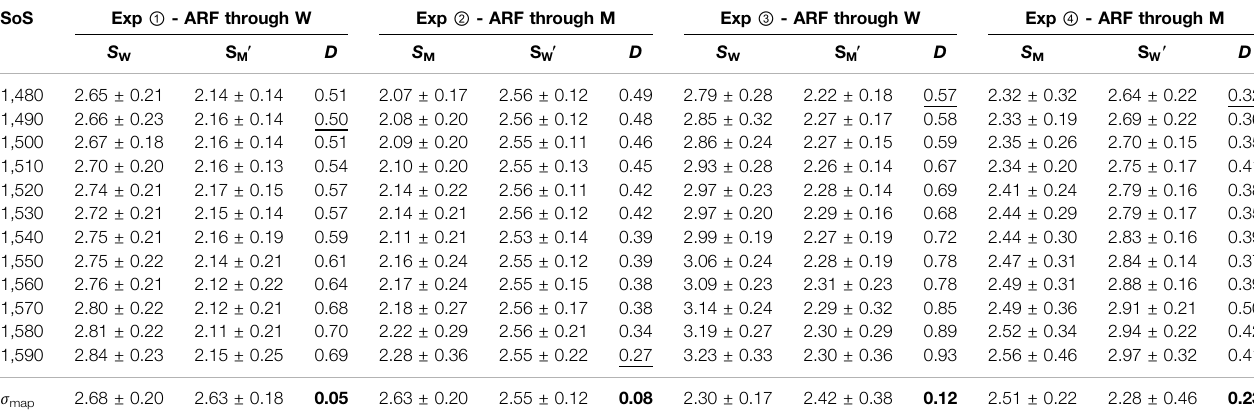
TABLE1| MeasuredSWSvaluesinROInearer( S )andfarther( S ′ )fromtheARFwhenimagedthroughwater(i.e., S W )andmuscle(i.e., S M ).Resultsareshownafterbeamformingwith difference constant SoS as well as a locally-varying SoS map ( σ map ). Minimum disparity D achieved across the beamforming settings is highlighted in bold for each experiment. SoS Exp ① - ARF through W Exp ② - ARF through